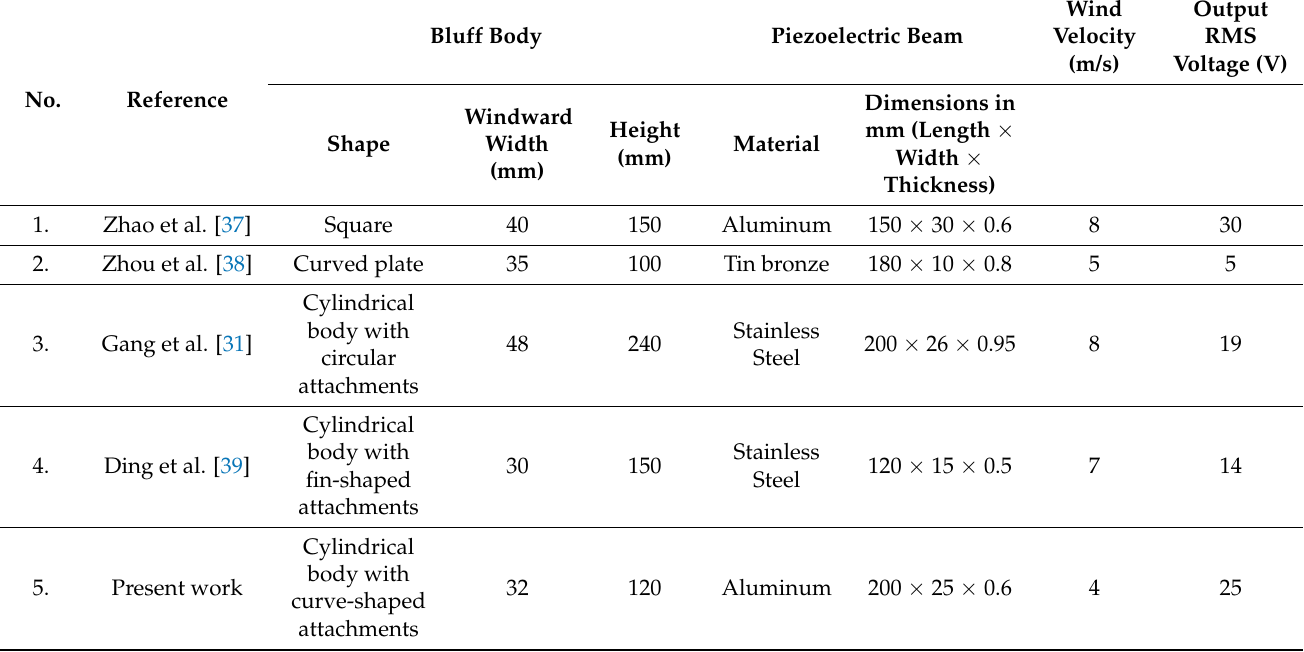
Table 2. Comparison results of the various piezoelectric galloping wind energy harvesters.